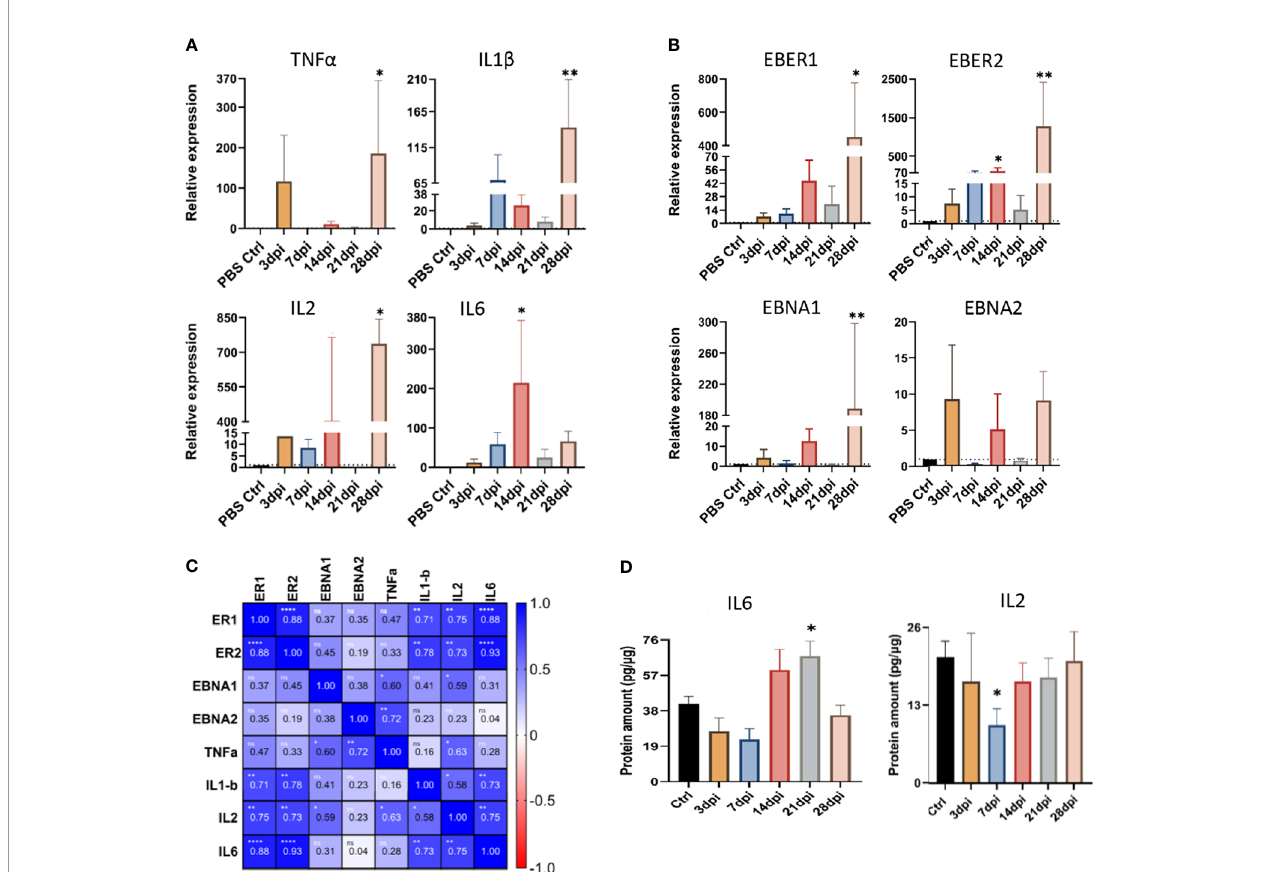
FIGURE 10 | Peripheral EBV infection results in altered expression of cytokines and viral transcripts in the brain. The expression of (A) cytokines (TNF a , IL1 b , IL2, and IL-6), and (B) EBV latent transcripts (EBER1, EBER2, EBNA1 and EBNA2), in the brain tissue harvested at 3, 7, 14, 21, and 28dpi, examined using qPCR. Data displayed as mean ± SEM. Comparisons were made using one-way ANOVA with Fisher ’ s LSD test or the nonparametric Kruskal-Wallis test. (C) Heat map of Spearman correlation of in fl ammatory and viral transcripts in the brain. Color mapping for positive and negative correlation are indicated in the legend on the right. ns: p >0.05, *p ≤ 0.05, **p ≤ 0.01, ****p ≤ 0.0001. (D) The levels of IL2 and IL6 proteins were measured by ELISA in brain tissues harvested at 3, 7, 14, 21 and 28dpi. Data displayed as mean ± SEM. Comparisons were made using one-way ANOVA with Fisher ’ s LSD test or Welch and Brown-Forsythe test. * p ≤ 0.05, ** p ≤ 0.01 compared to PBS controls. Bars without asterisks are not signi fi cantly different from the PBS